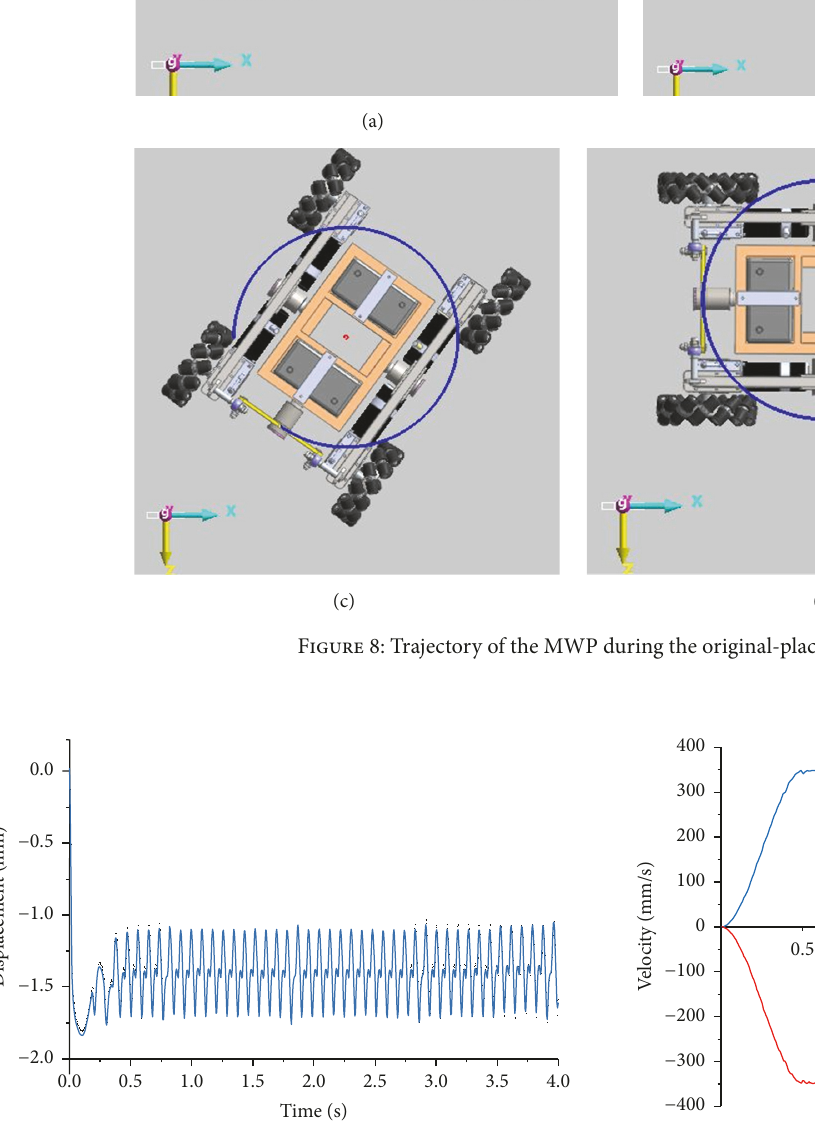
Figure 9: Displacement-time curve in the 𝑌 direction in straight- line motion.